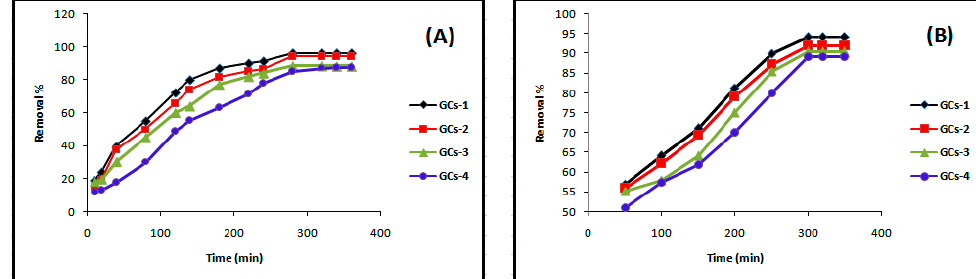
Figure 5. Influence of contact time on ( A ) nickel and ( B ) copper sorption.